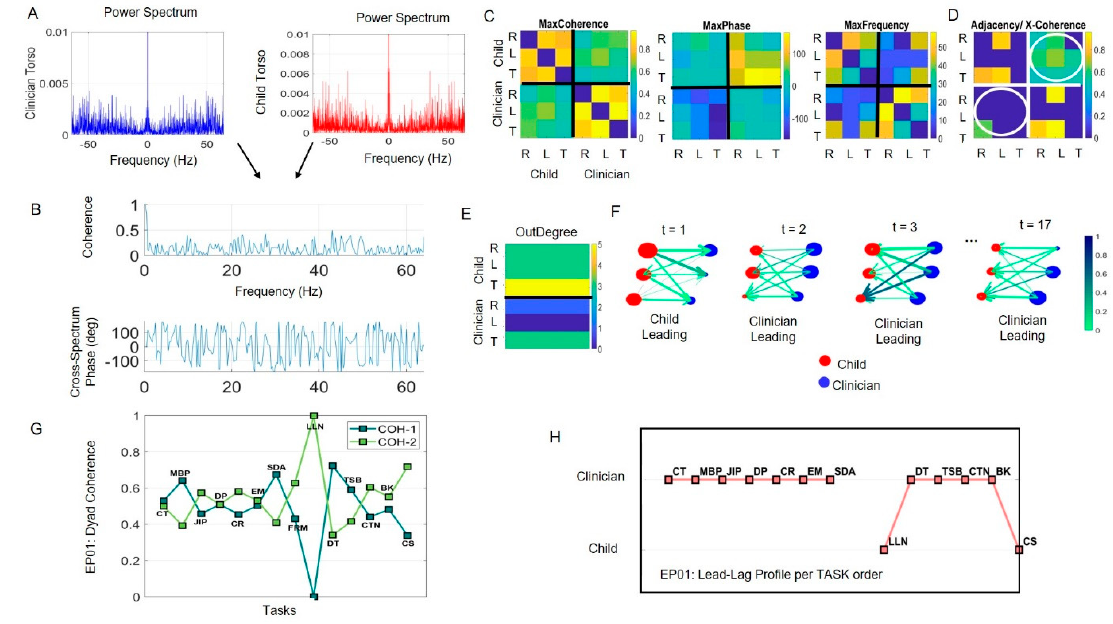
Figure 2. Analytical pipeline and visualization tools. ( A ) Frequency domain power spectrum analysis of pairwise sensor data provides input to obtain cross coherence spectrum phase across frequencies. ( B ) and ( C ) A parameterization of the data into three corresponding matrices: MaxCoherence, MaxPhase, MaxFrequency. Each entry contains the maximal cross coherence value obtained pairwise across all sensors. For example, row 1 contains the values for the child’s right wrist (R) sensor in relation to all other sensors (child left wrist L, child torso T, clinician right wrist R, clinician left wrist L, and clinician torso T. Dyad entries of the matrix are at the right upper quadrant (child → clinician) and left lower quadrant (clinician → child). Self-interaction entries are at the left upper quadrant (child) and the right lower quadrant (clinician). Corresponding entries in the MaxPhase matrix reflect the phase value at which the pairwise coherence is maximal while the same entry in the MaxFrequency reflect the corresponding frequency value. ( D ) Adjacency matrix used to represent a dynamically changing weighted connected graph is obtained by retaining the entries at positive phase under convention i → j for the (i,j) entry. Dyadic interaction entries are circled. ( E ) Outdegree for each node denotes the number of links from that node to other nodes. ( F – H ) Visual tools and sample metrics to characterize socio-motor behaviors in social dyads. ( F ) Visualizing the network to track its states as they dynamically change in the Construction Task for a child-clinician dyad (EP01, with 17-unit times of 12 s time length for each sample under Independent Identically Distributed (IID) assumption, explained in Methods). The size of the node corresponds to the OutDegree value, the arrow’s color is the maximum cross-coherence value, the thickness is the phase value and the direction comes from the computation involving Outdegree (see methods.) ( G ) Sample profile over tasks of Experimental Participant 01, EP01 showing the COH1 and COH2 unfolding within the session. These terms are used to obtain a socio-motor metric (see Methods.) ( H ) Lead profile for the dyad involving EP01 and revealing the clinician prevalent leadership for most tasks, but Loneliness (LLN) and Creating a Story (CS), where the child leads (please see Supplementary Material Table S2 for task description and